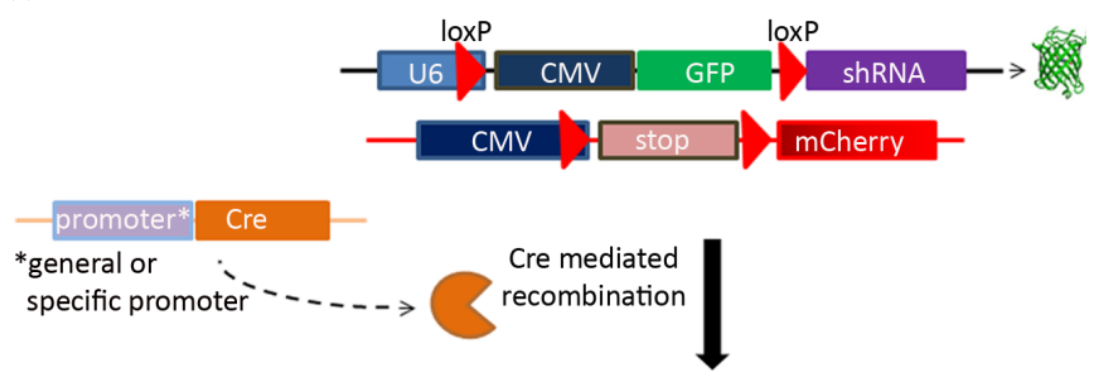
Figure 2. Design and mode of action for conditional knockdown approaches mediated by Cre recombinase. ( a ) Example of a strategy for Cre-mediated shRNA activation. Three DNA constructs are electroporated into the brain: a Cre recombinase under the control of a general or cell-specific promoter, an shRNA containing a DNA stuffer sequence flanked by loxP sites between a U6 pol III promoter and the shRNA coding sequence, and a fluorescent protein (mCherry) containing a stop cassette flanked by loxP sites between a general promoter (CMV) and the mCherry coding sequence. The stuffer sequence of the shRNA plasmid contains GFP under the control of a general promoter (CMV), therefore without Cre activity GFP is expressed. Upon Cre-mediated recombination, the stuffer sequence and the stop cassette are excised and thereafter the shRNA and mCherry fluorescent protein are expressed. ( b ) Example of a strategy for Cre-mediated shRNA inactivation. As in (a), three DNA constructs are electroporated: a Cre recombinase under the control of a general or cell-specific promoter, an shRNA that also contains a GFP marker such that both shRNA and GFP are flanked by loxP sites, and a fluorescent protein (mCherry) containing a stop cassette flanked by loxP sites between a general promoter (CMV) and the mCherry coding sequence. Without Cre activity both GFP and the shRNA are expressed. Upon Cre-mediated recombination, the shRNA and GFP are excised, turning off their expression. Similar to (a), mCherry expression is activated following Cre-mediated recombination. ( c ) The Cre-loxP system can be used to label sparse cells. Cells are electroporated with three constructs: a fluorescent protein (GFP) containing a stop cassette flanked by loxP sites between a general promoter (CMV) and the GFP coding sequence, an RNAi construct, and a Cre recombinase under the control of a general or cell-specific promoter. Titration of the amount of the Cre construct results in partial expression, where a small fraction of the cells expresses Cre. While all cells are expressing the shRNA, only the cells with a Cre recombinase construct express GFP. ( d ) Implementation of the Cre-loxP system in the developing cortex labels sparse cells and allows detailed analysis of their morphology. Embryos were electroporated at E12.5 and harvested at E13.5 (our unpublished data). A Cre-loxP system as described at (c) was used to sparsely label post-mitotic neurons. The Cre recombinase was under the control of Tubulin (cid:302) promoter.